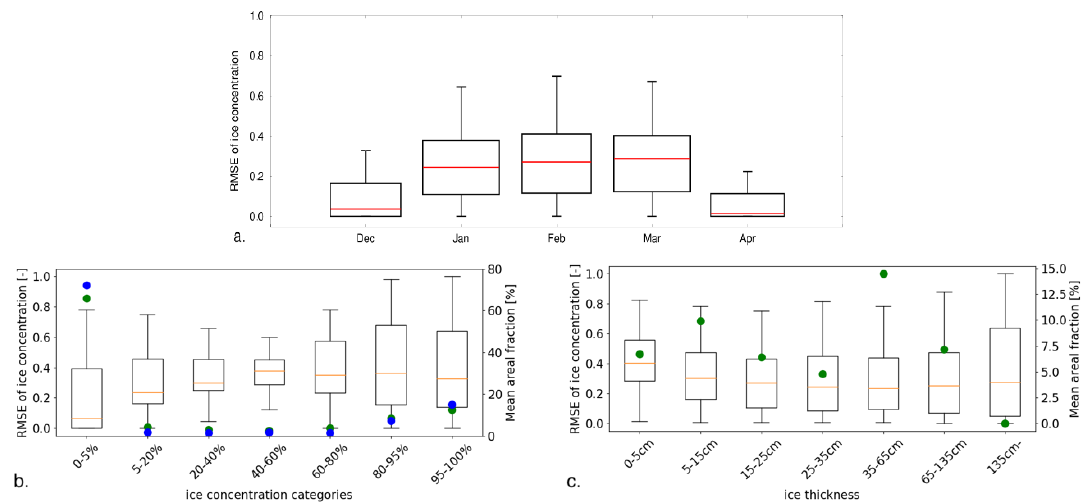
Figure 5. Ranges of spatial concentration RMSE as functions of ( a ) months, ( b ) observed ice concentration, and ( c ) modeled ice thickness for the LEOFS 2005-2017 simulation results. A box extends from the lower and upper 25% of the RMSEs. A horizontal line within each box denotes the median value. The whiskers show the range of RMSE, extending from the box toward farthest data points within the interquartile range (i.e., length of the box) from the upper and lower bounds of the box. In ( b , c ), solid circles show mean areal fractions for observation (blue) and model (green), representing data frequency for each category. For ( c ), open water cells are excluded.